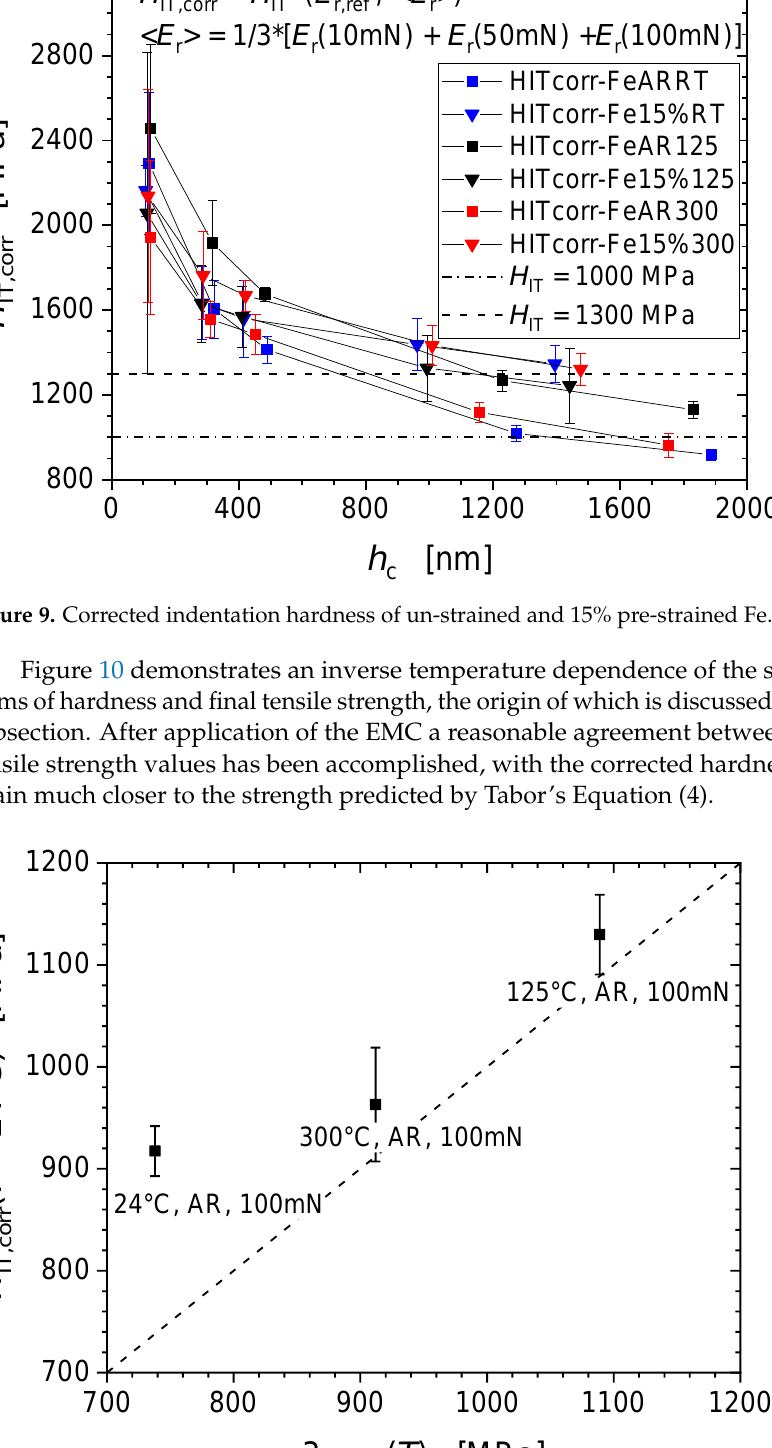
Figure 8. Reduced modulus values obtained from nanoindentation measurements and used for EMC procedure.